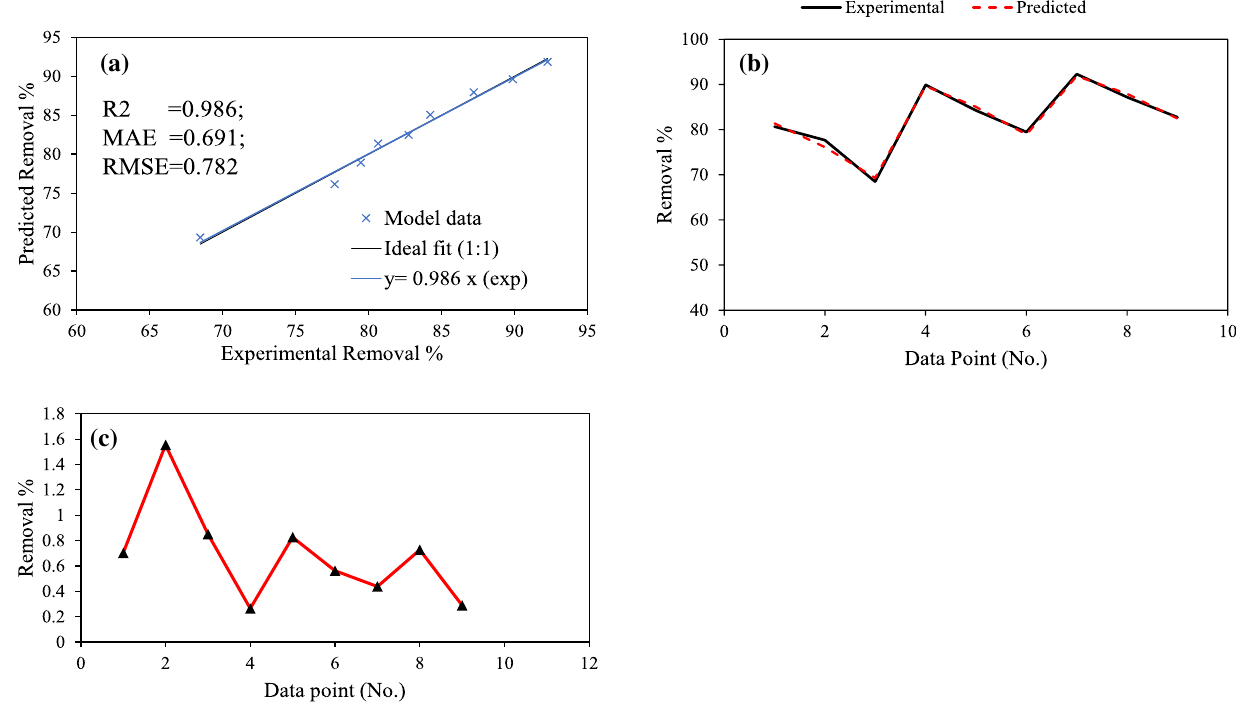
Fig. 4 Performance of the R TiO